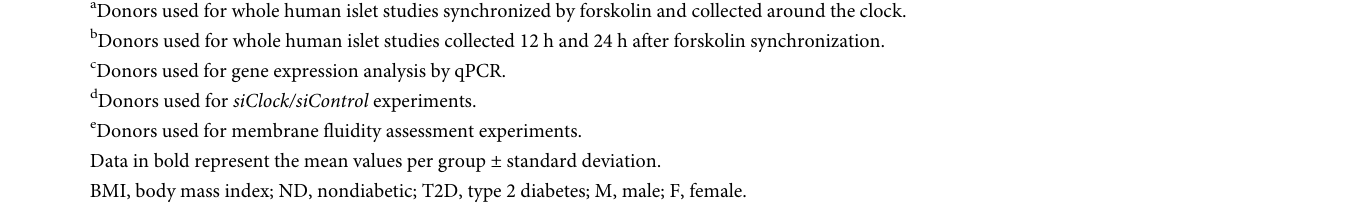
Characteristics of non-T2D (ND) islet